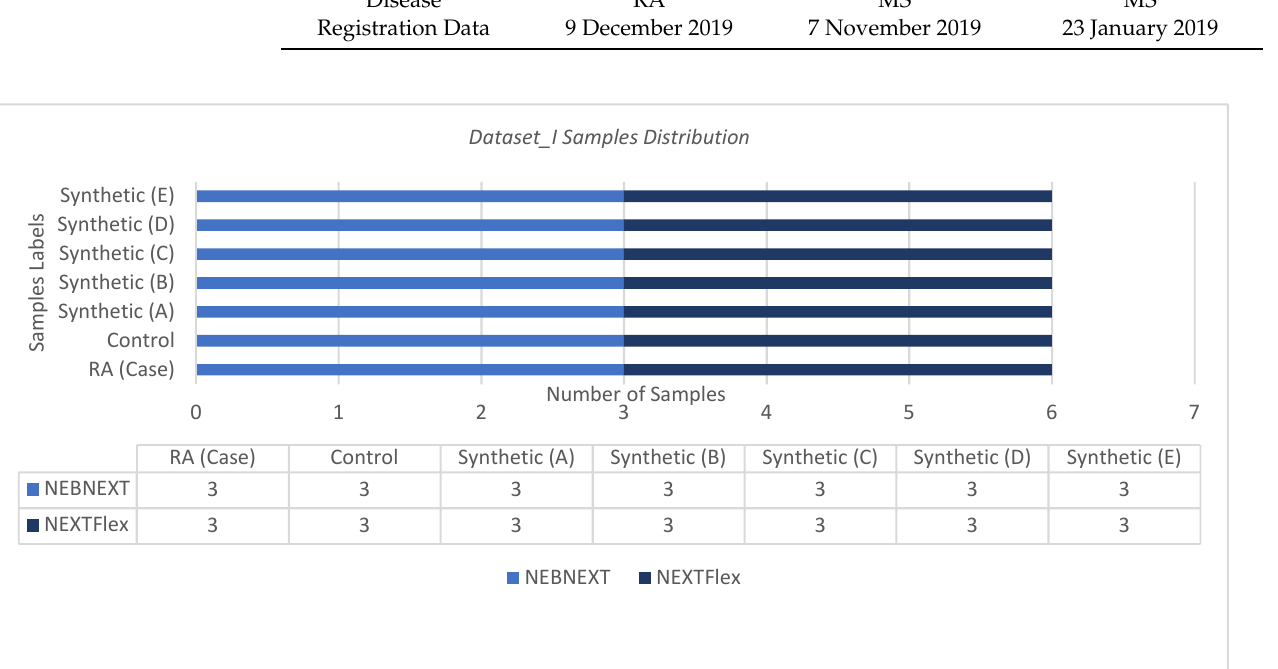
Figure 1. Dataset_I samples’ class distribution. In total, 50% of the samples were prepared using